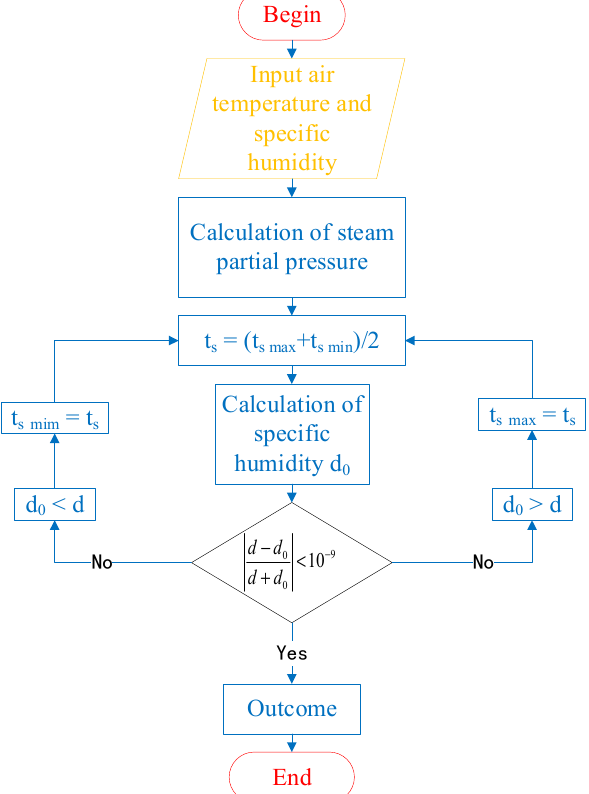
Figure 5. Flow chart of wet air mode solution.